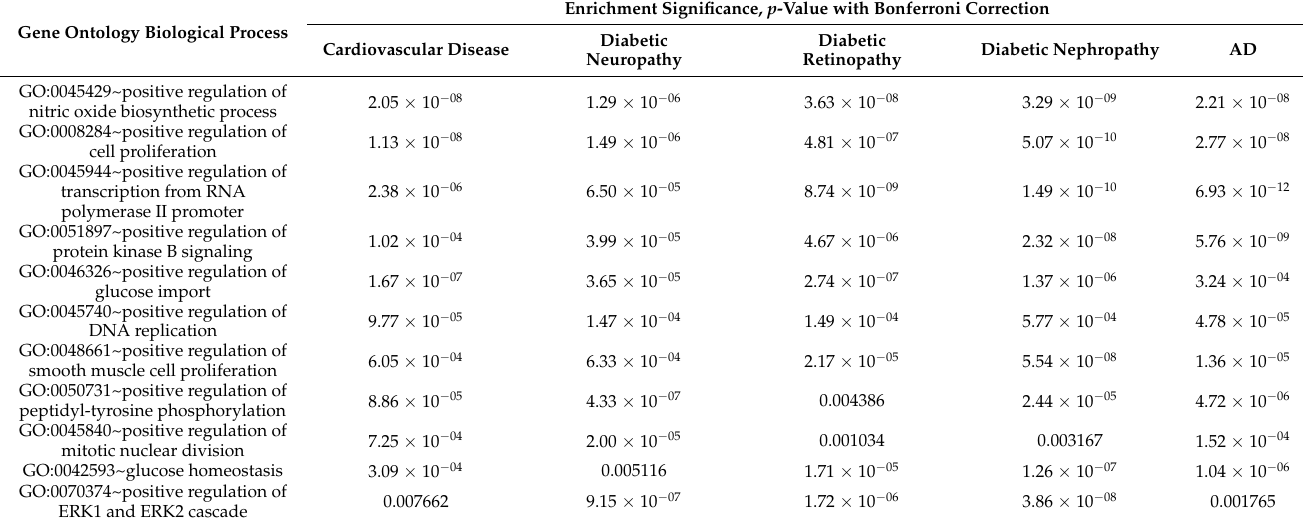
Gene Ontology Biological